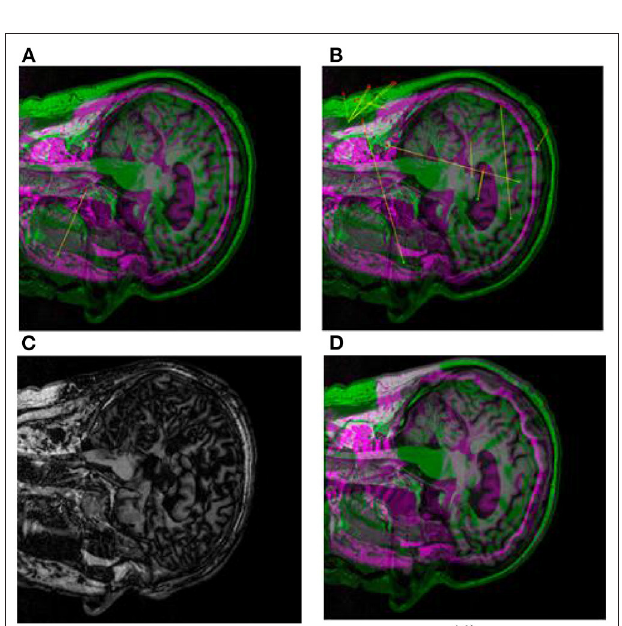
FIGURE 9 | Segmental registration images of brain CT-MRI and PET images. (A) shows the pre-processed initial registration image. (B) medical images after multi-modal registration. (C) is affine transformation global rough registration of medical images. (D) represents the medical image after non-rigid transformation and high-precision registration, and the addition of false color is convenient for physicians to